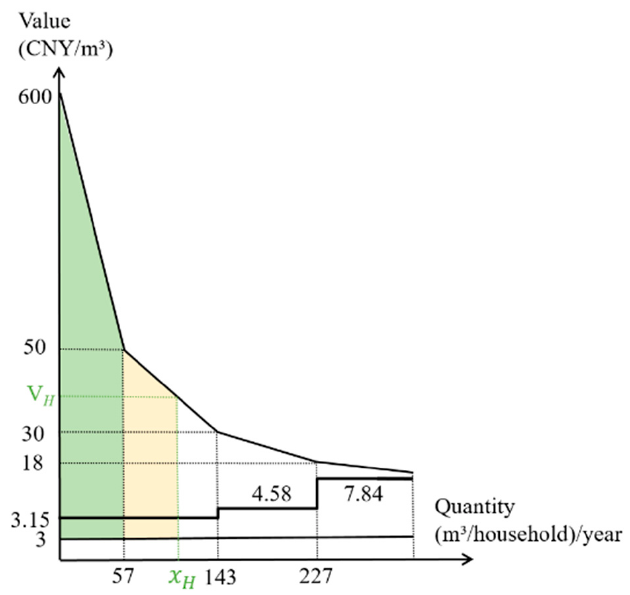
Figure 7. The demand function of households .